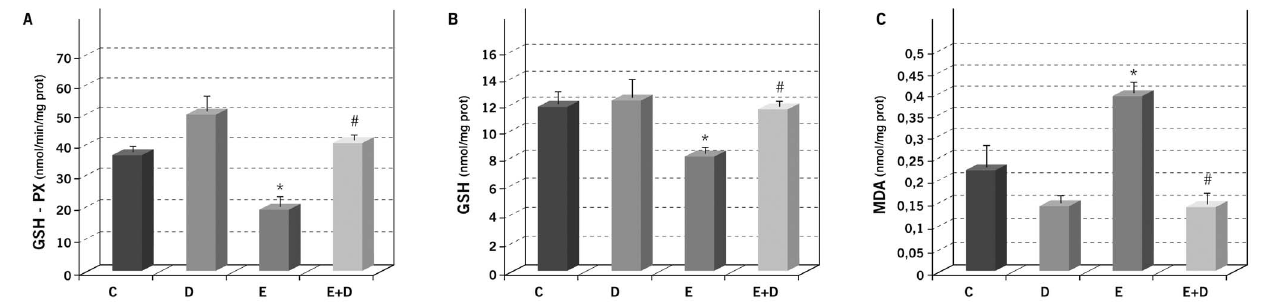
Figure 3. Effect of Daclizumab on endotoxin-induced oxidative stress in rat eyes. Glutathione peroxidase activity (A), glutathione (B) and malondialdehyde (C) concentrations were measured in the eye homogenates of the different study groups. Each value represents the mean 6 SE.